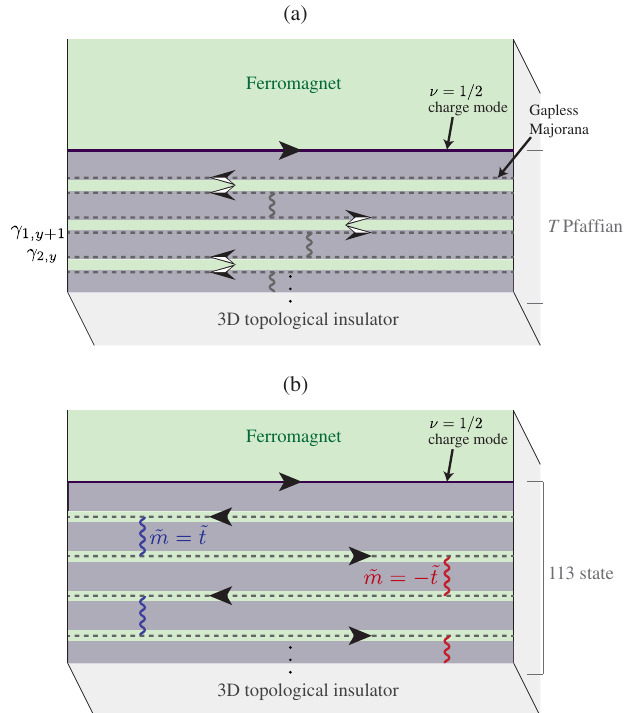
FIG. 4. (a) Interface between the symmetric T-Pfaffian surface topological order and a trivial magnetically gapped region in the extrinsic construction. To construct the T-Pfaffian the neutral fermions from Fig. 3(b) are decomposed into a pair of Majorana modes γ 1 ;y and γ 2 ;y . The Majoranas then gap out by hybridizing with counterpropagating modes as indicated by wavy lines. An unpaired chiral Majorana mode necessarily remains at the inter- face, together with a gapless ν ¼ 1 = 2 charge mode arising from the uppermost quantum Hall strip. (b) Interface between the breaking 113 surface topological order and a trivial magnetically gapped region. Dashed lines represent neutral fermions dimerized in two possible ways depending on whether ~ m ¼ ~ t or ~ m ¼ − ~ t . In one case the interface supports only a ν ¼ 1 = 2 charge mode; in the other a counterpropagating ν ¼ 1 neutral mode